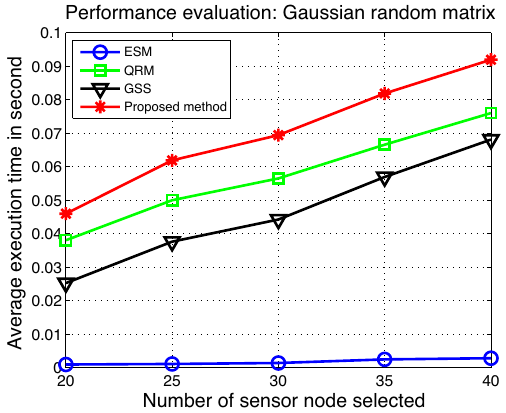
Fig. 3 Execution time in second with respect to various parameter dimensions for Gaussian random matrix H : the proposed algorithm is compared with different selection methods by varying the dimension of the parameter, | S | =